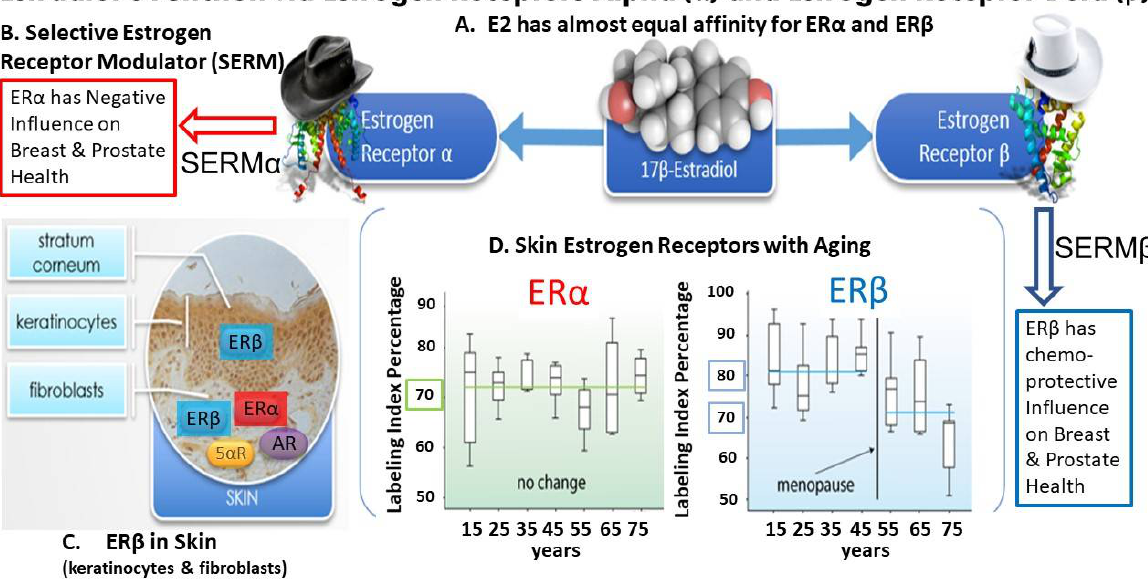
Figure 3. ( A ) The chemical filling model of 17 β -estradiol shows almost equal affinity for estrogen receptor (ER) alpha ( α ) and ER beta ( β ) [8]; ( B ) Selective estrogen receptor modulators (SERMS) are compounds that have agonist properties to preferentially bind to ER α or ER β , where SERMS binding ER β have positive while SERMs binding ER α have negative impact on breast and prostate health; ( C ) displays the distribution of ER α (red), ER β (blue), the 5 α -reductase enzyme (5 α -R in gold) that converts testosterone to the more potent androgen, 5 α -dihydrotestosterone or 5 α -DHT; and androgen receptor (AR in purple); ( D ) displays the labeling index (percentage) for ER α (red label with green shading) and ER β (blue label with blue shading) with age in